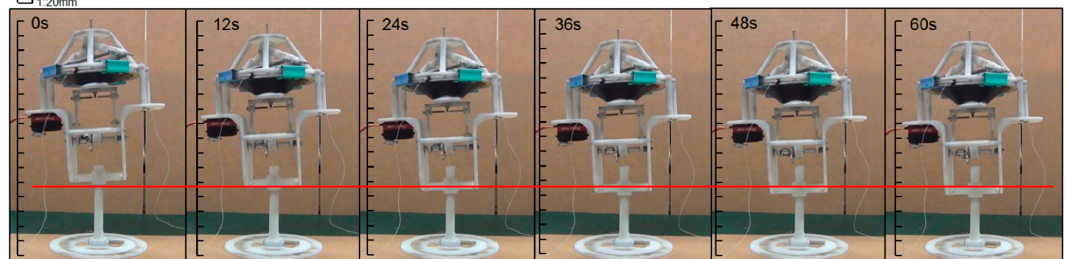
Figure 13. The energy storage process of the jumping robot.